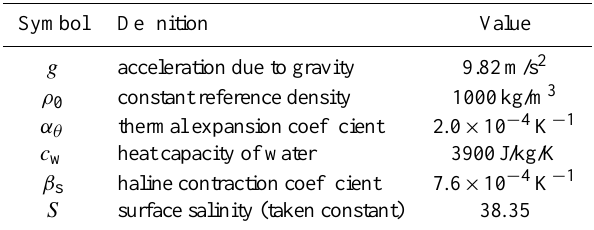
Table 2. Definition and value of the parameters used in the surface buoyancy flux